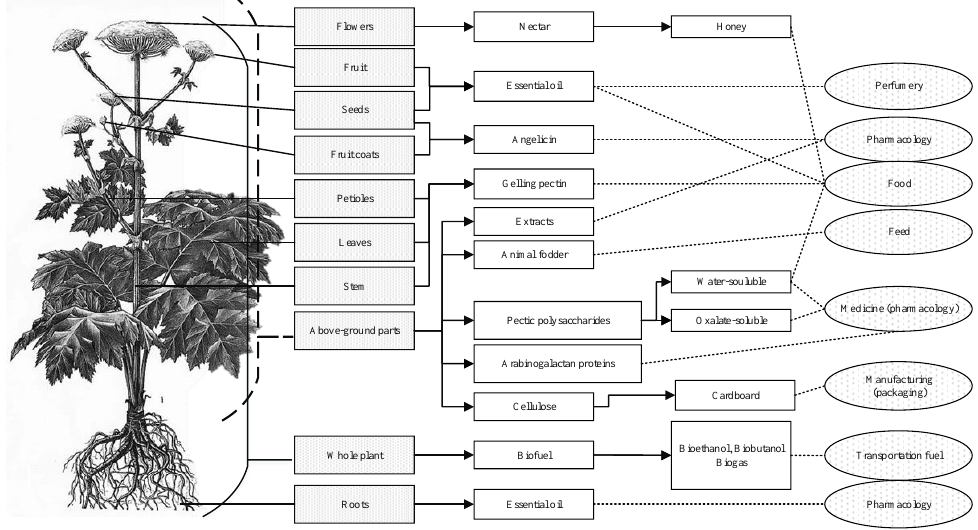
Fig. 4. Product classification according to the parts of the resource to be